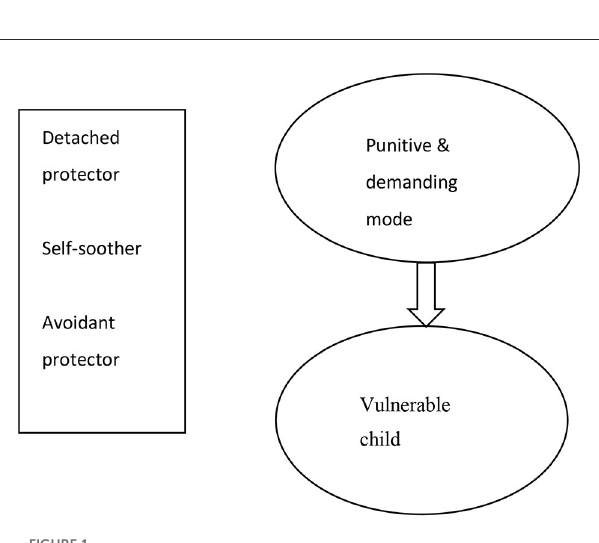
FIGURE1 Schema mode model of the